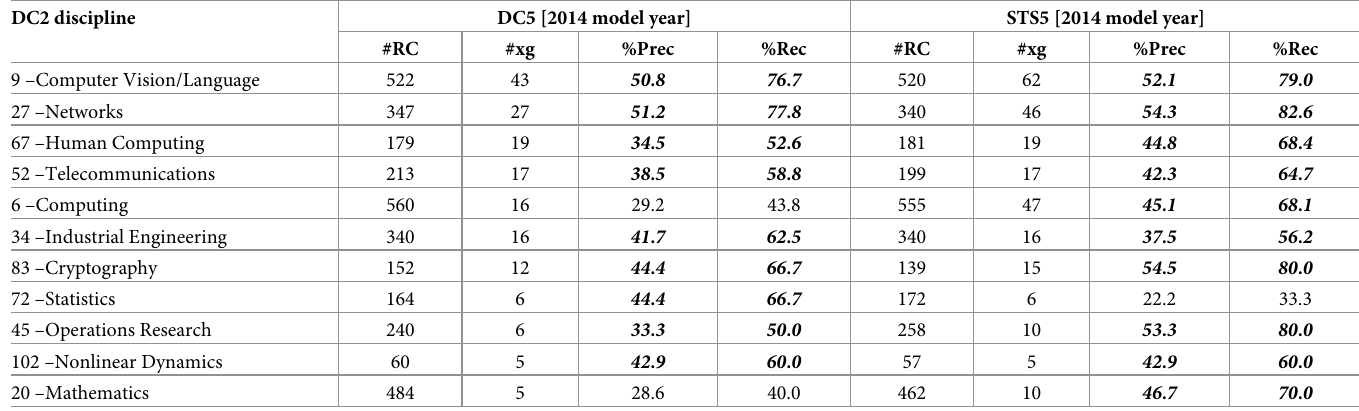
Table 7. Precision (%prec) and recall (%rec) for the eleven DC2 disciplines in the Computing Technology field in both models using the 2014 model year. DC2 discipline